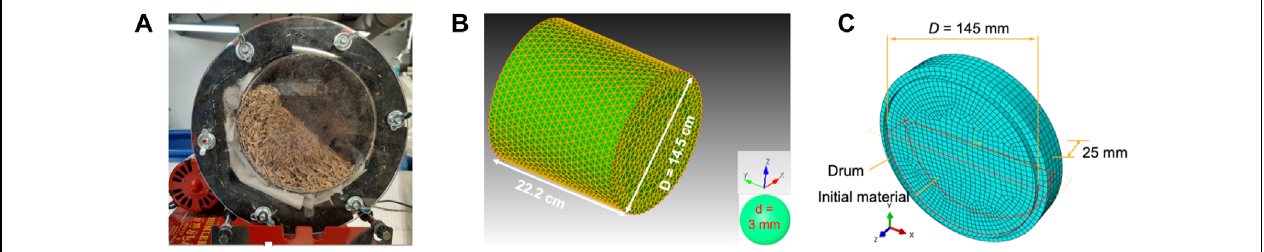
FIGURE 6 | Rotating drum test configuration: the experimental set-up (A) ; the DEM model set-up with the same dimension as the experiment (B) ; and the geometrical configuration of the FEM model (C) .